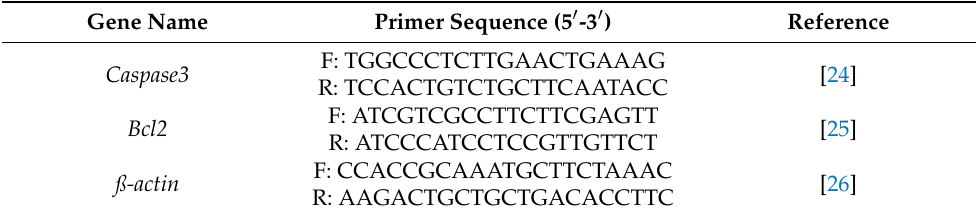
Table 2. Primer pairs sequences of caspase3, Bcl2, and β -actin genes. Gene